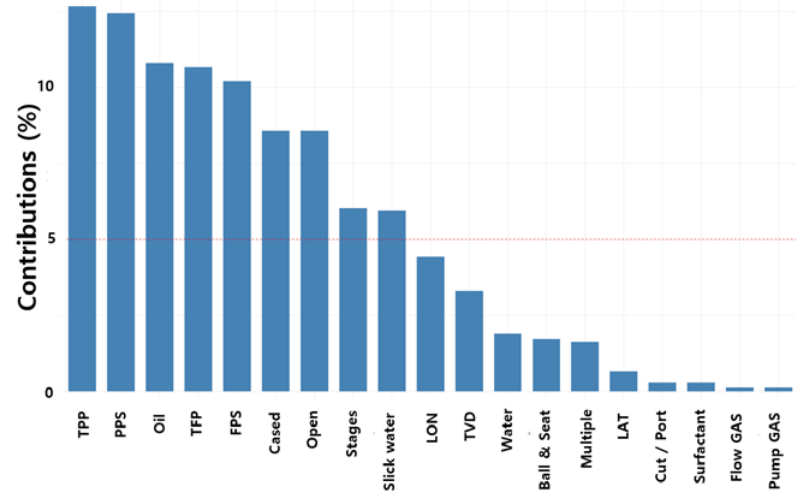
Figure 10. The contribution of the variable of the sum of PC1 and PC2 to explain the variability in PCA. Table 5. Comparison of performance metrics of after principal component analysis.